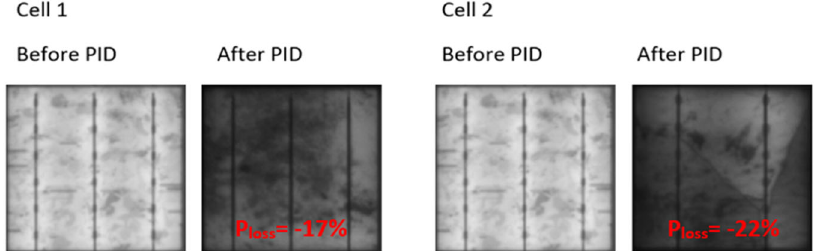
Fig. 1 EL images were taken before and after the PID test. The EL images are captured using Brightspot EL imaging setup, and the power loss (P loss ) was estimated under the standard test conditions.